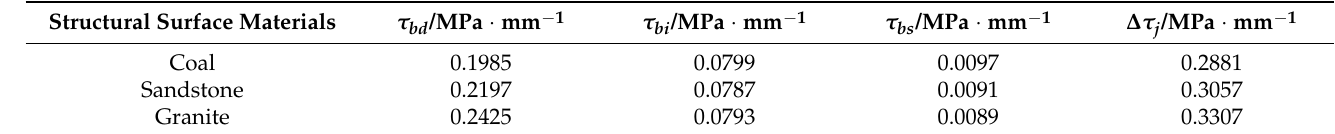
Table 7. Shear strengths of bolt-reinforced structural surfaces at unit shear displacement.